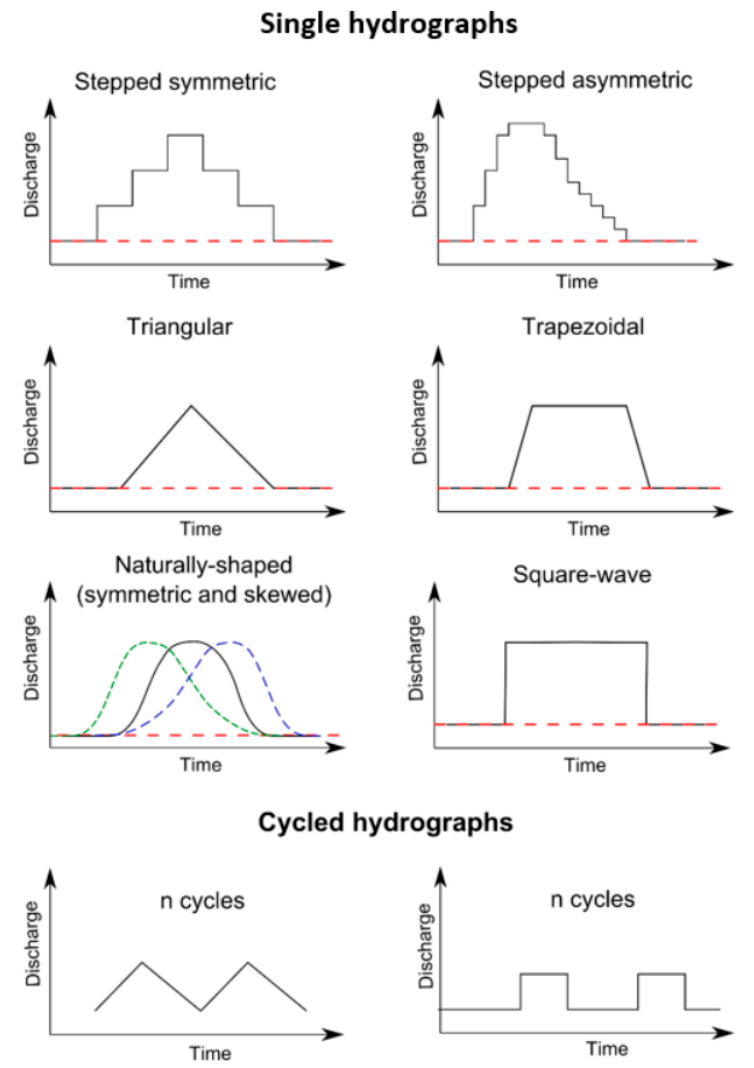
Figure 1. Main types of unsteady flow hydrographs tested in laboratory experiments. The dotted red line denotes a base flow.